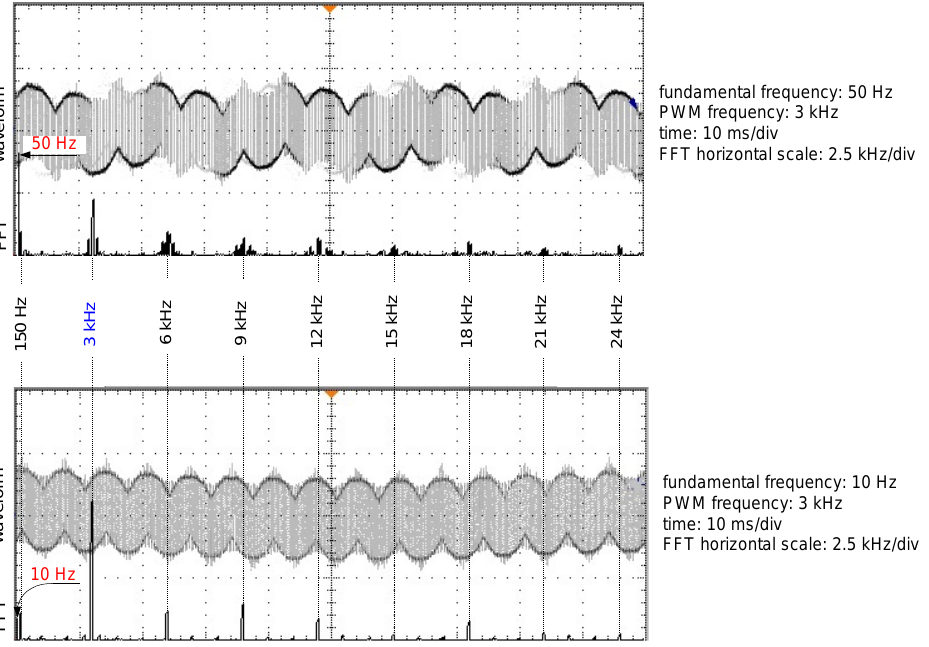
Figure 5. Oscillograms of the earth fault current in a variable-speed drive circuit (earth fault at the motor terminals). Upper oscillogram: the motor is supplied by frequency 50 Hz (rated motor speed); lower oscillogram: the motor is supplied by frequency 10 Hz (slow motor speed); pulse width modulation (PWM) frequency: 3 kHz.